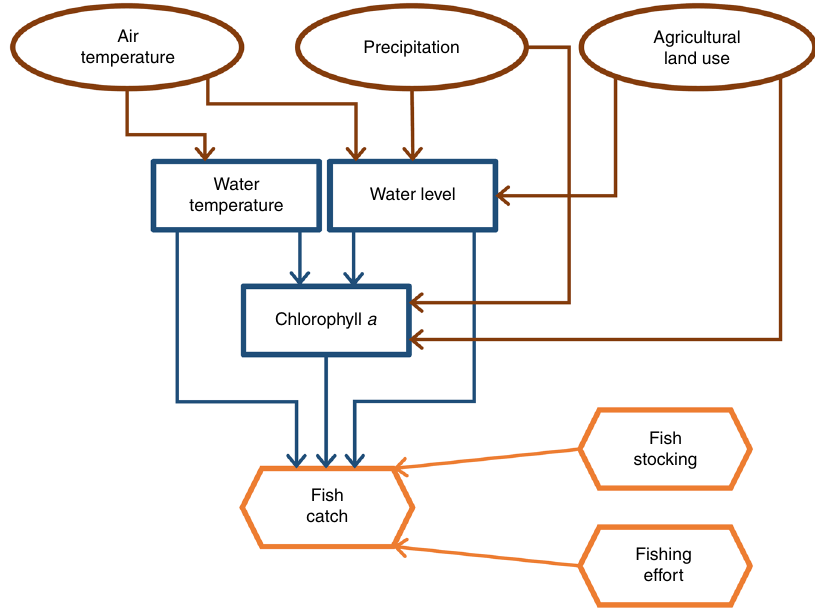
Fig. 2 Hypothesized causal processes represented in the Bayesian networks model. Variables associated with catchment climate and land use are in oval-brown boxes. Variables associated with lake environment are in blue-rectangular boxes. Variables associated with fi sh catch, fi sh stocking, and fi shing effort are in orange-hexagon boxes.